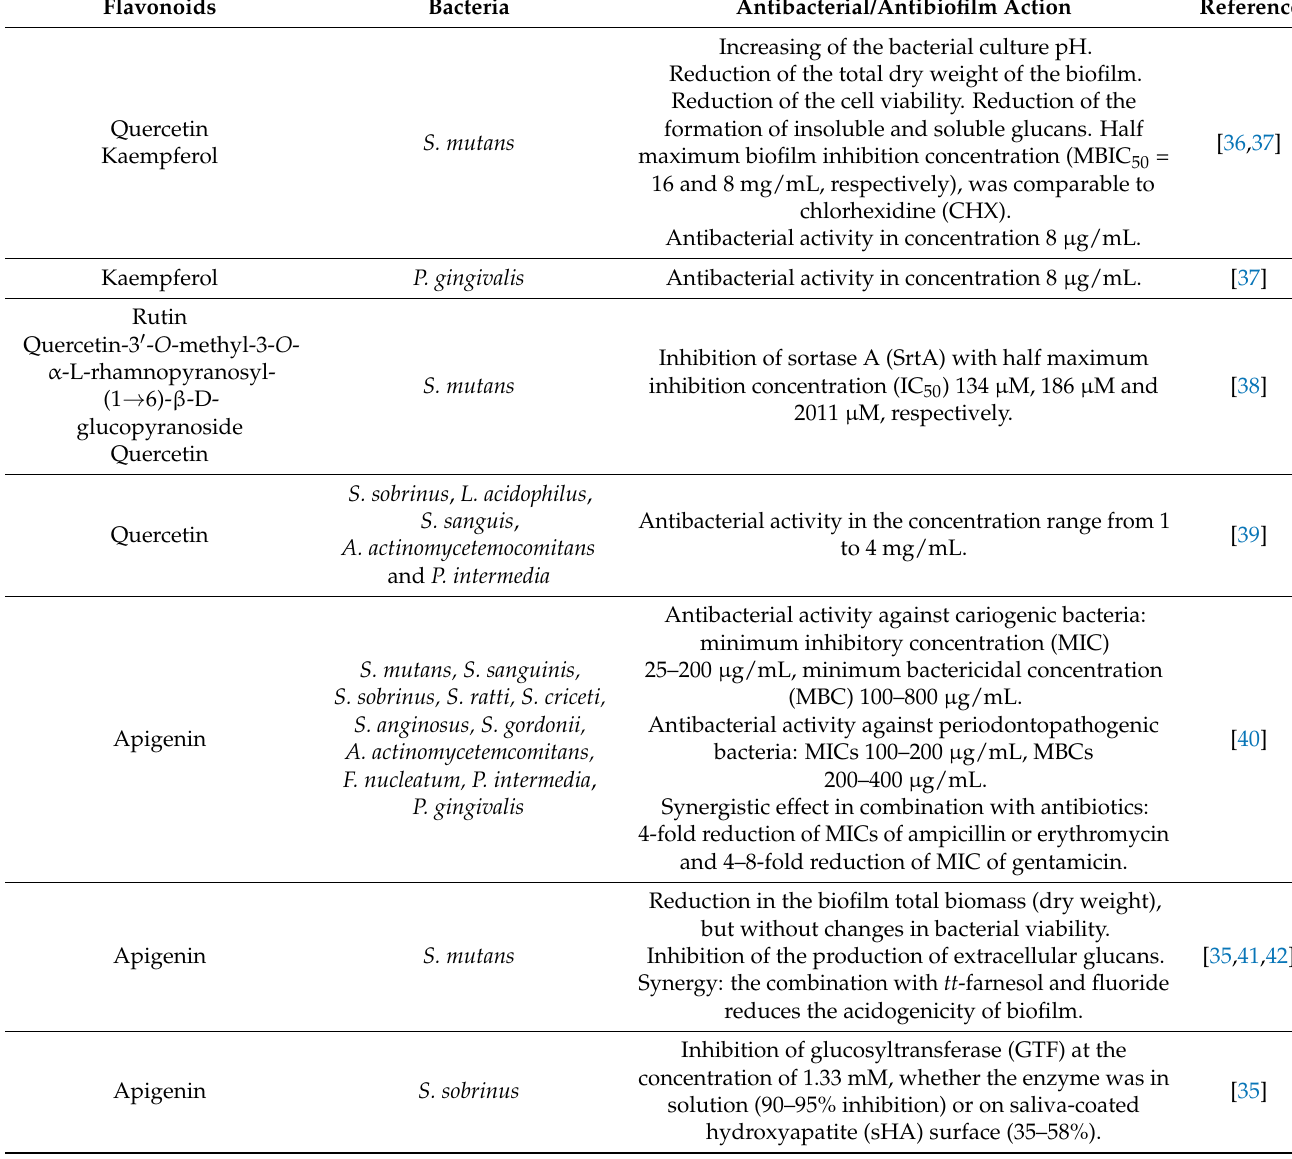
Table 3. Antibacterial/antibiofilm effects of the most abundant